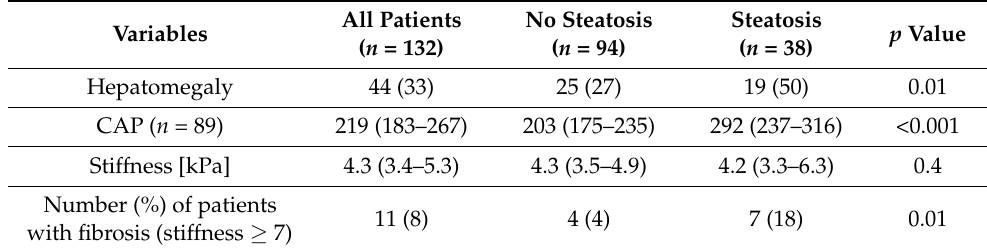
Table 2. Findings of hepatic ultrasound and